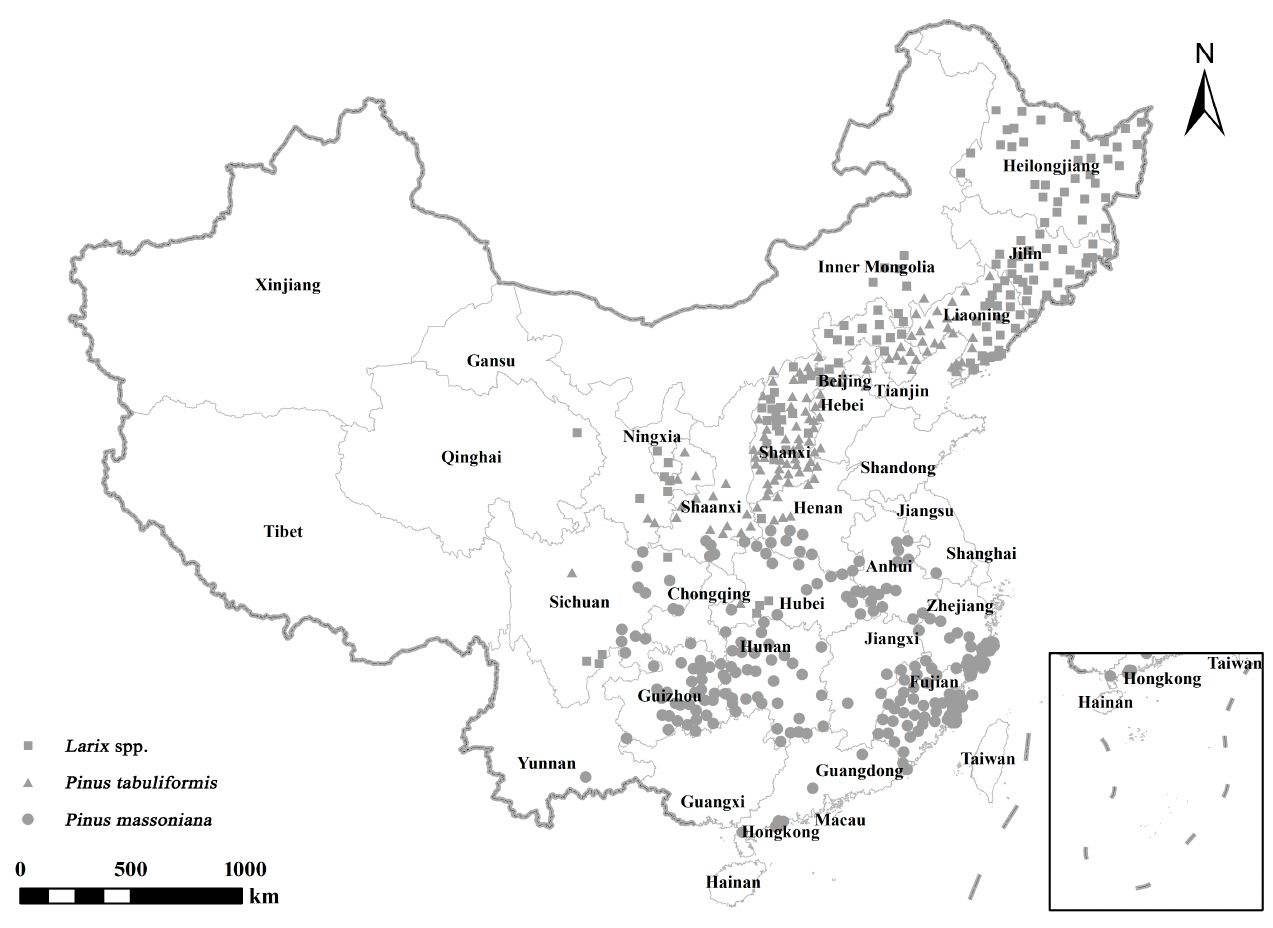
Figure 1. Location of sample plots in China. Table 1. The statistical characteristics of modeling variables for three types of plantations.